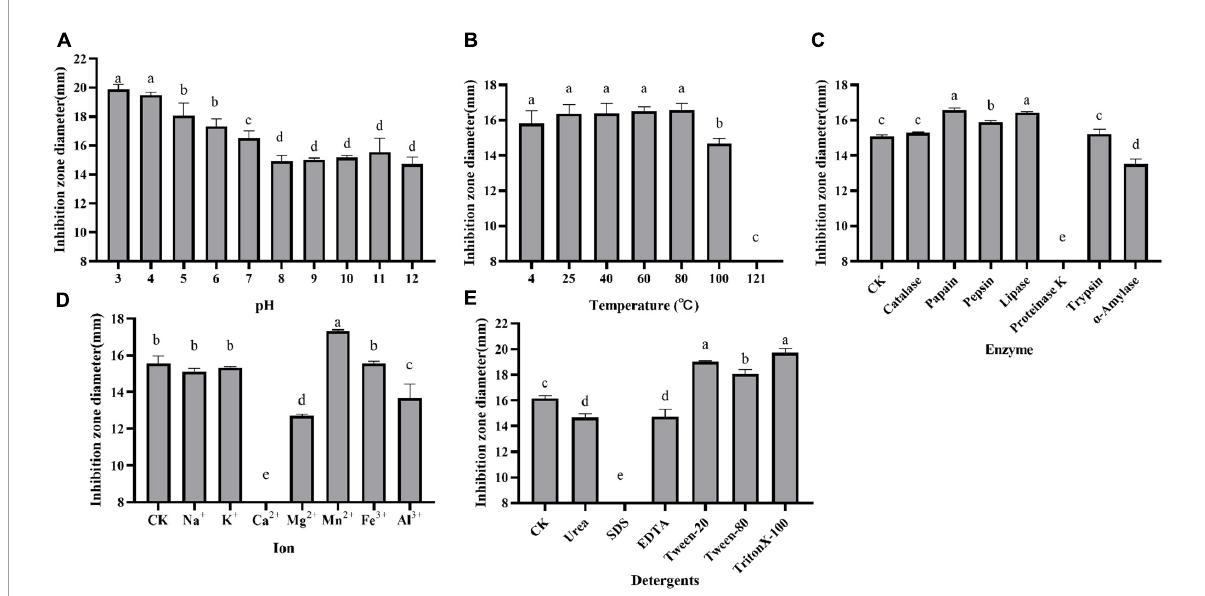
FIGURE2 Effect of pH (A) , temperature (B) , enzymes (C) , metal ions (D) , and detergents (E) on the antagonistic activity of supernatant against E. coli ATCC 25922. Inhibition zone diameter is expressed as the mean of three replicates, and the vertical bar indicates the standard deviation, each column followed by the same letter is not significantly different at the 5%